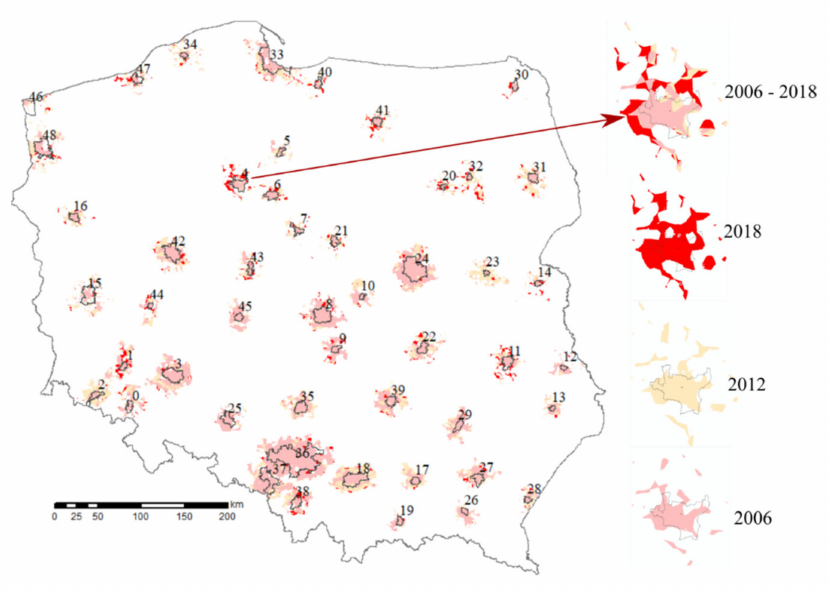
Figure 23. The areas related to urban use separated for the three moments of time 2006, 2012 and 2018. Source: own elaboration.